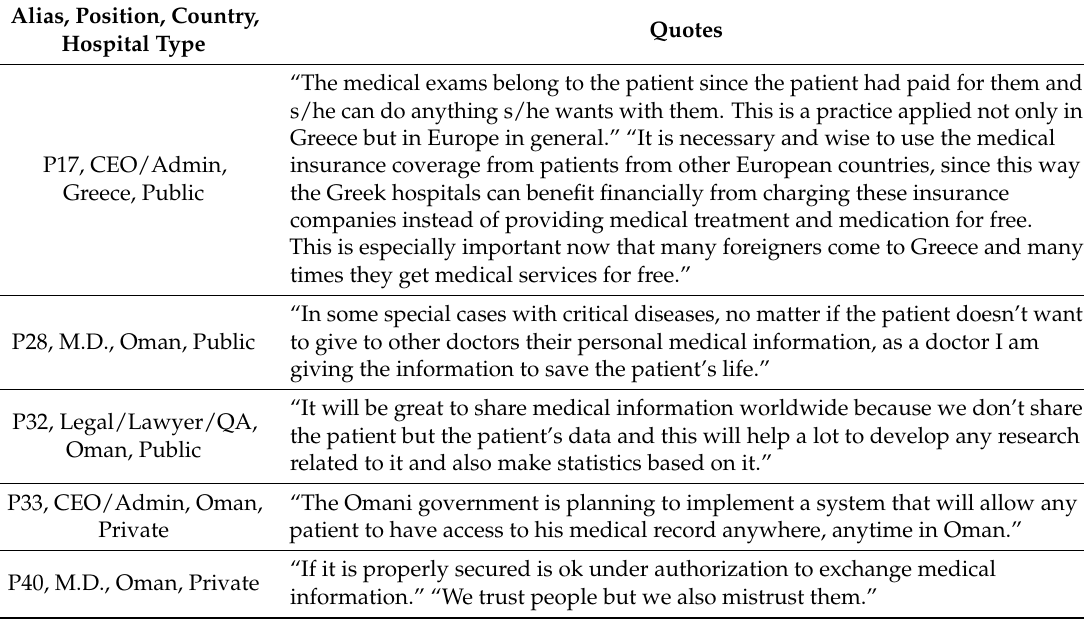
Table 3. Sharing medical records—significant